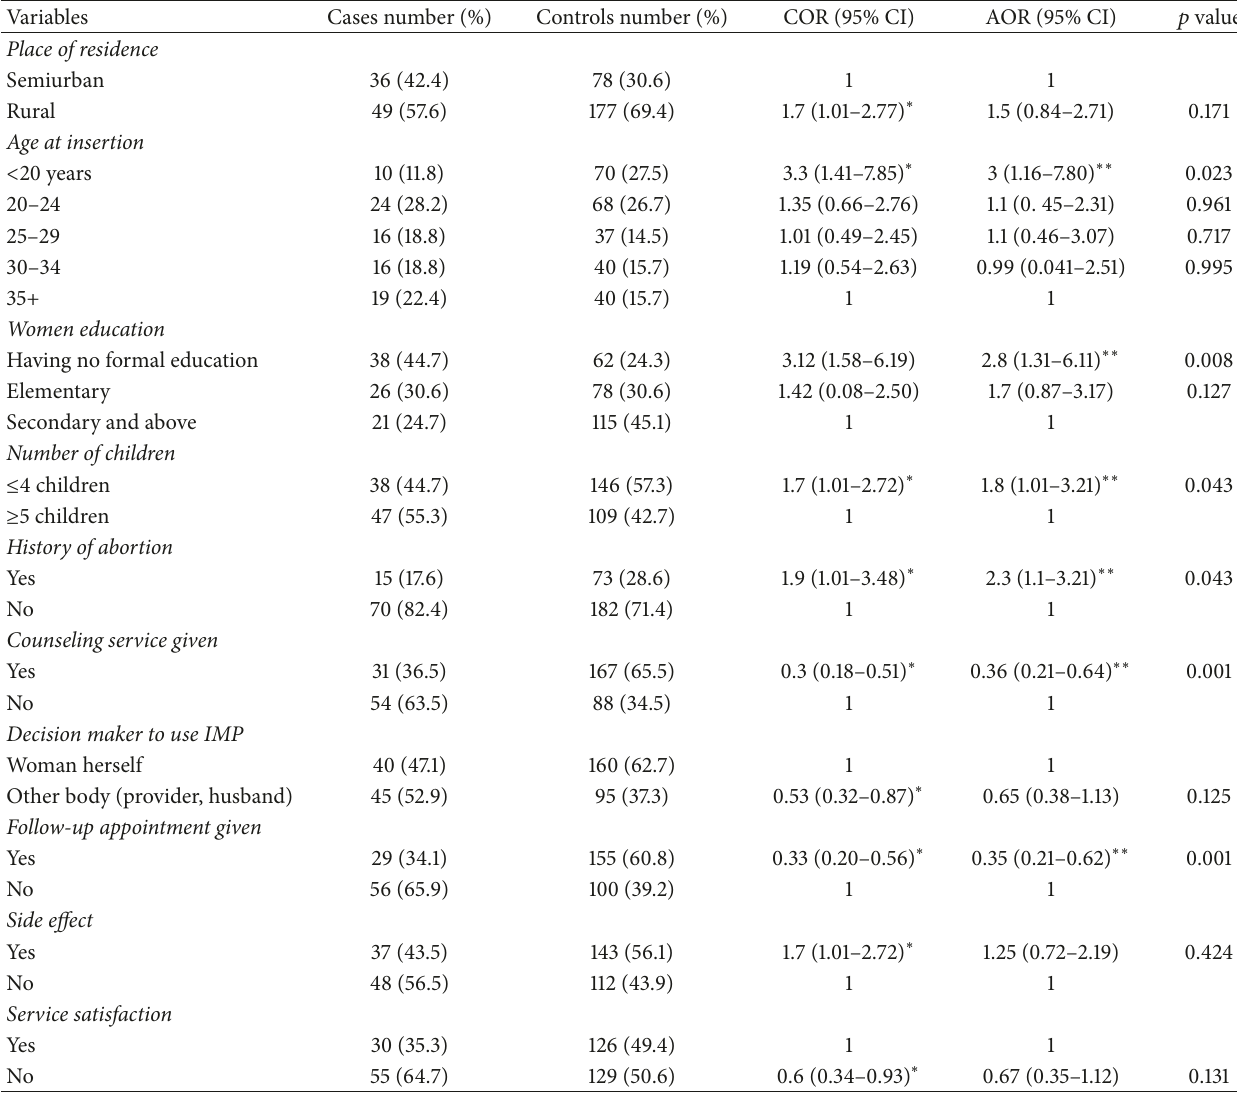
Table 3: Factors associated with discontinuation of Implanon among women who ever used Implanon in Diguna Fango District, Wolayita Zone, Southern Ethiopia, March 2017 ( 𝑛 = 340